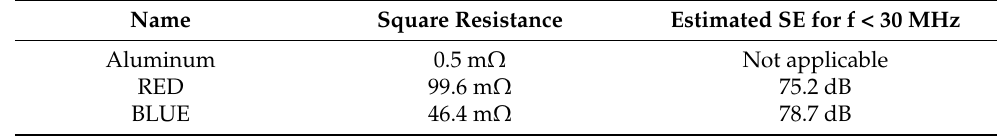
Table 4. Shielding effectiveness measurements using DC square resistance